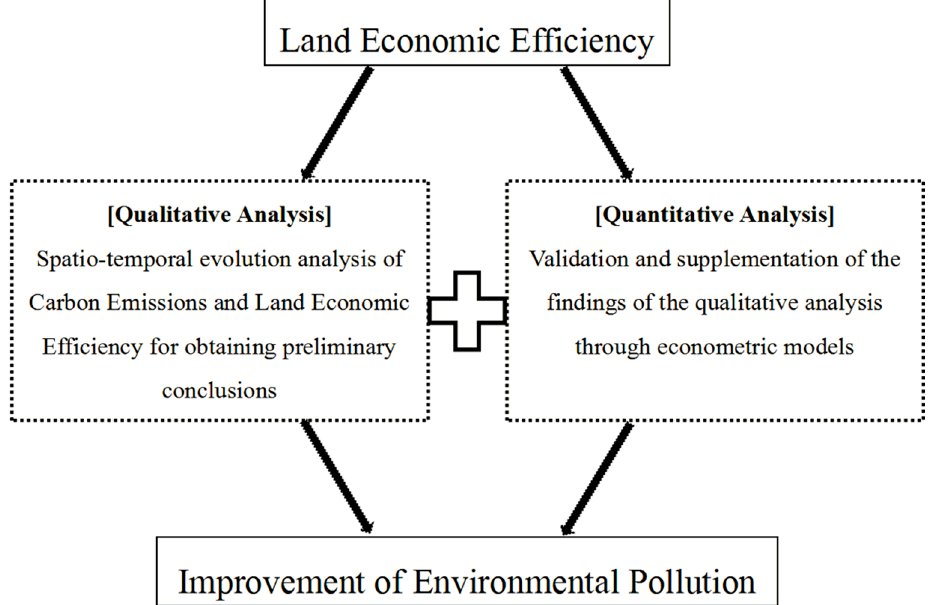
Figure 2. Methodological framework.